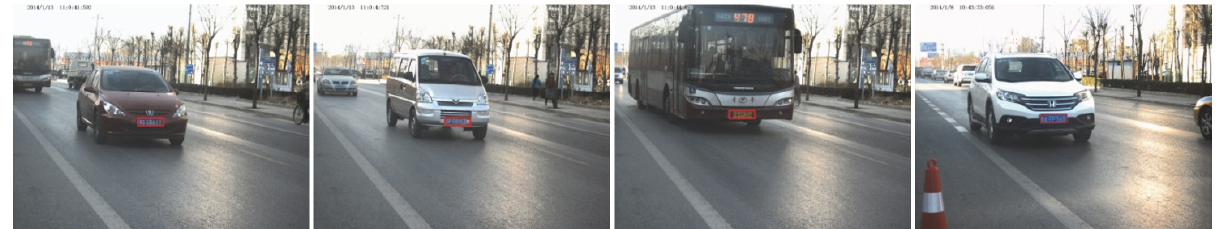
Figure 4: The license plate detection results with our